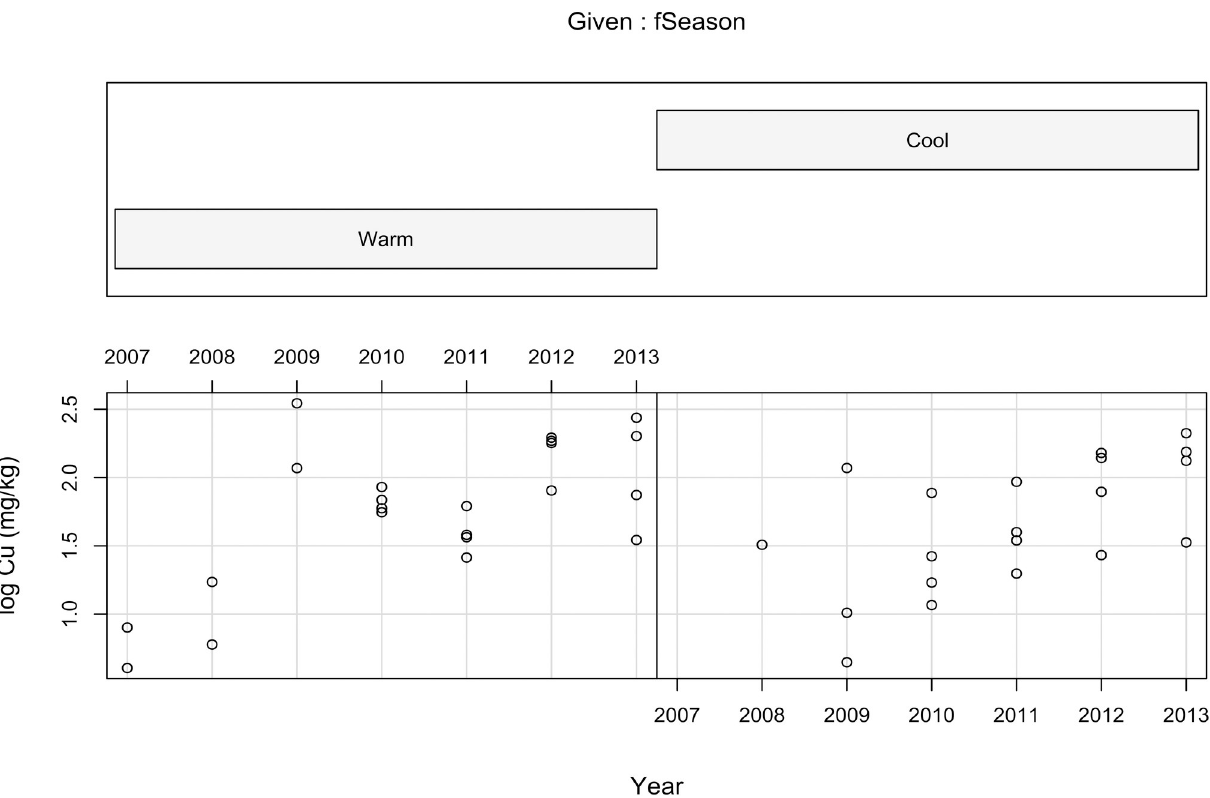
Fig 2. Conditioning plot showing the pattern of log 10 Cu deposition in surface sediments (mg kg -1 ) throughout the years 2007–2013 in the warm vs the cool seasons.